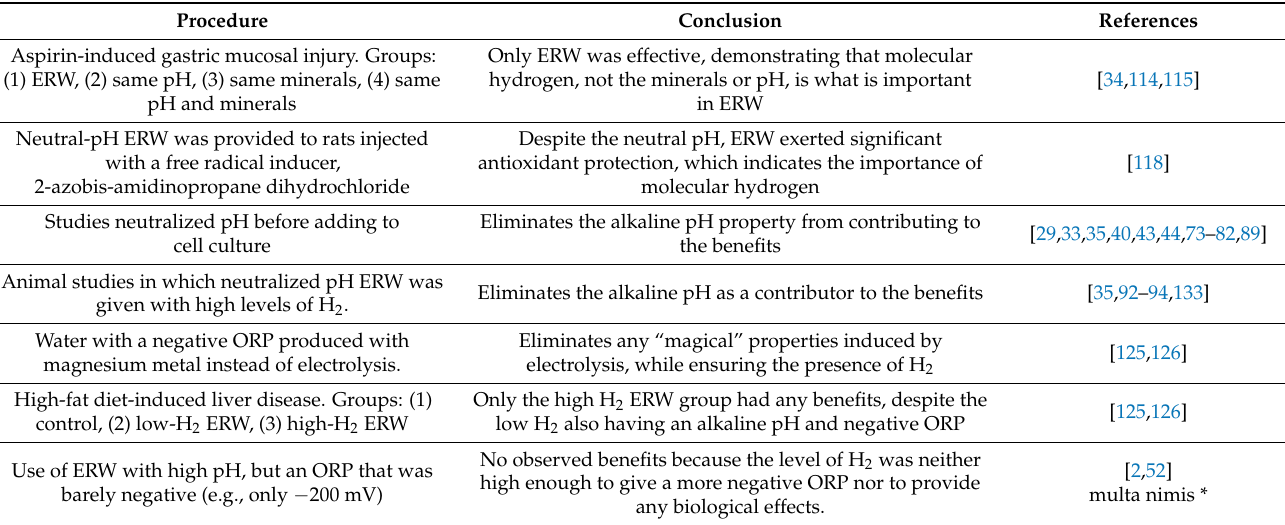
Table 3. Summarized evidence demonstrating H 2 is the therapeutic agent in